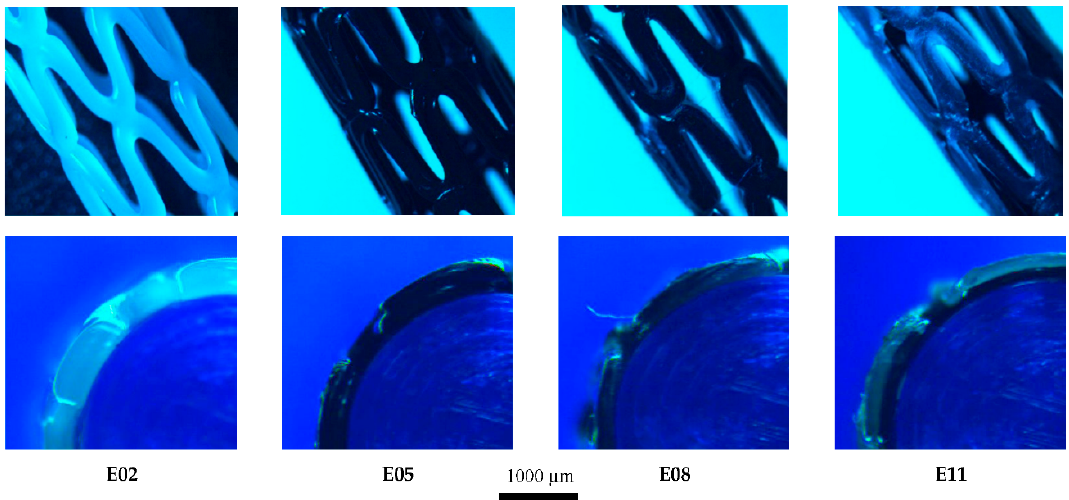
Figure 6. Optical Nikon Microscope images of 3D-printed stents. Superior images show the general 3D view, while inferior images depict the ¼ section radial view. Samples numbered according to Table 3. PCL/PLA composite stent fabrication parameters.